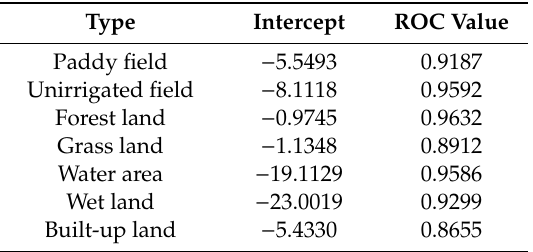
Table 5. ROC values of the logistic regression model.